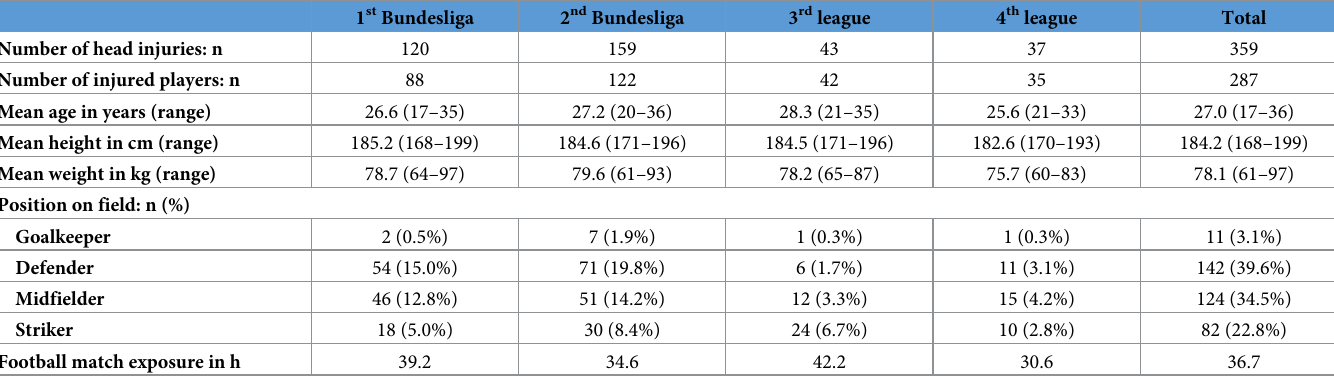
Table 1. Anthropometric data of football players with a head injury determined by video analysis.